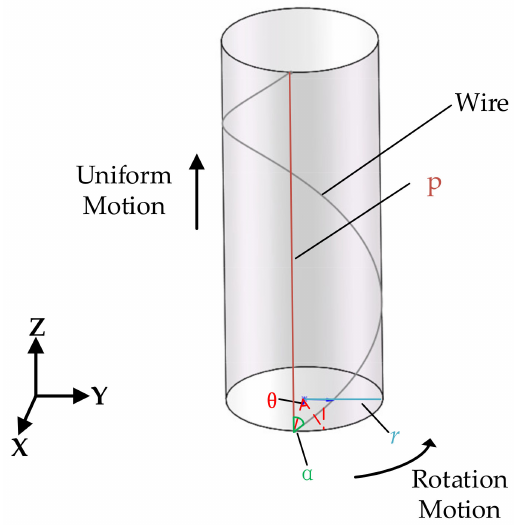
Figure 3. The trajectory of the braiding wire.